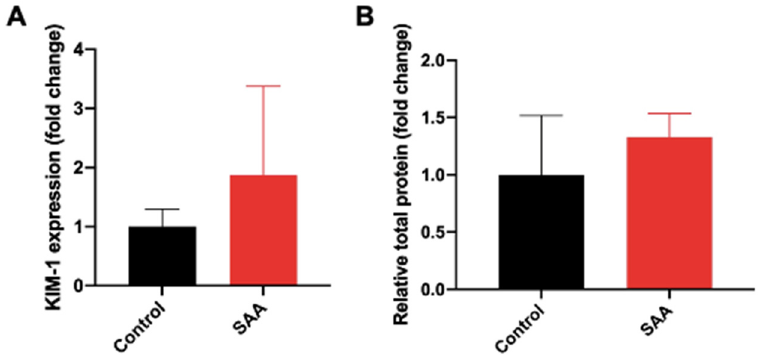
Figure 3. Assessment of renal function following SAA administration. ( A ) Male ApoE − / − mice were randomly allocated to vehicle control (administered 100 µL PBS every 3 days for 2 weeks) and the SAA group (administered 12 µg SAA protein every 3 days for 2 weeks). Kidney tissue was harvested 4 weeks after cessation of treatment, and a portion of renal tissue was homogenised for biochemical analyses. An immunoassay ELISA kit to quantify renal KIM-1 expression was utilised to assess renal dysfunction. Reagents, standards and samples were prepared and assayed by ELISA as per the manufacturer’s instructions (Abcam). Absorbance values were measured at 450 nm with values for concentration calculated from the standard curve generated. ( B ) Total urinary protein concentration; all data shown as relative mean ± SD.